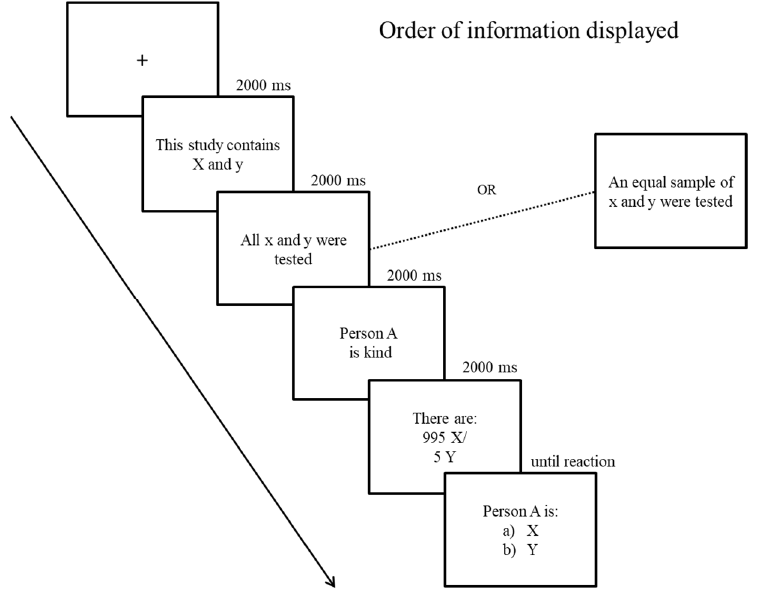
Figure 2. Procedure for rapid-response base-rate task (Experiment